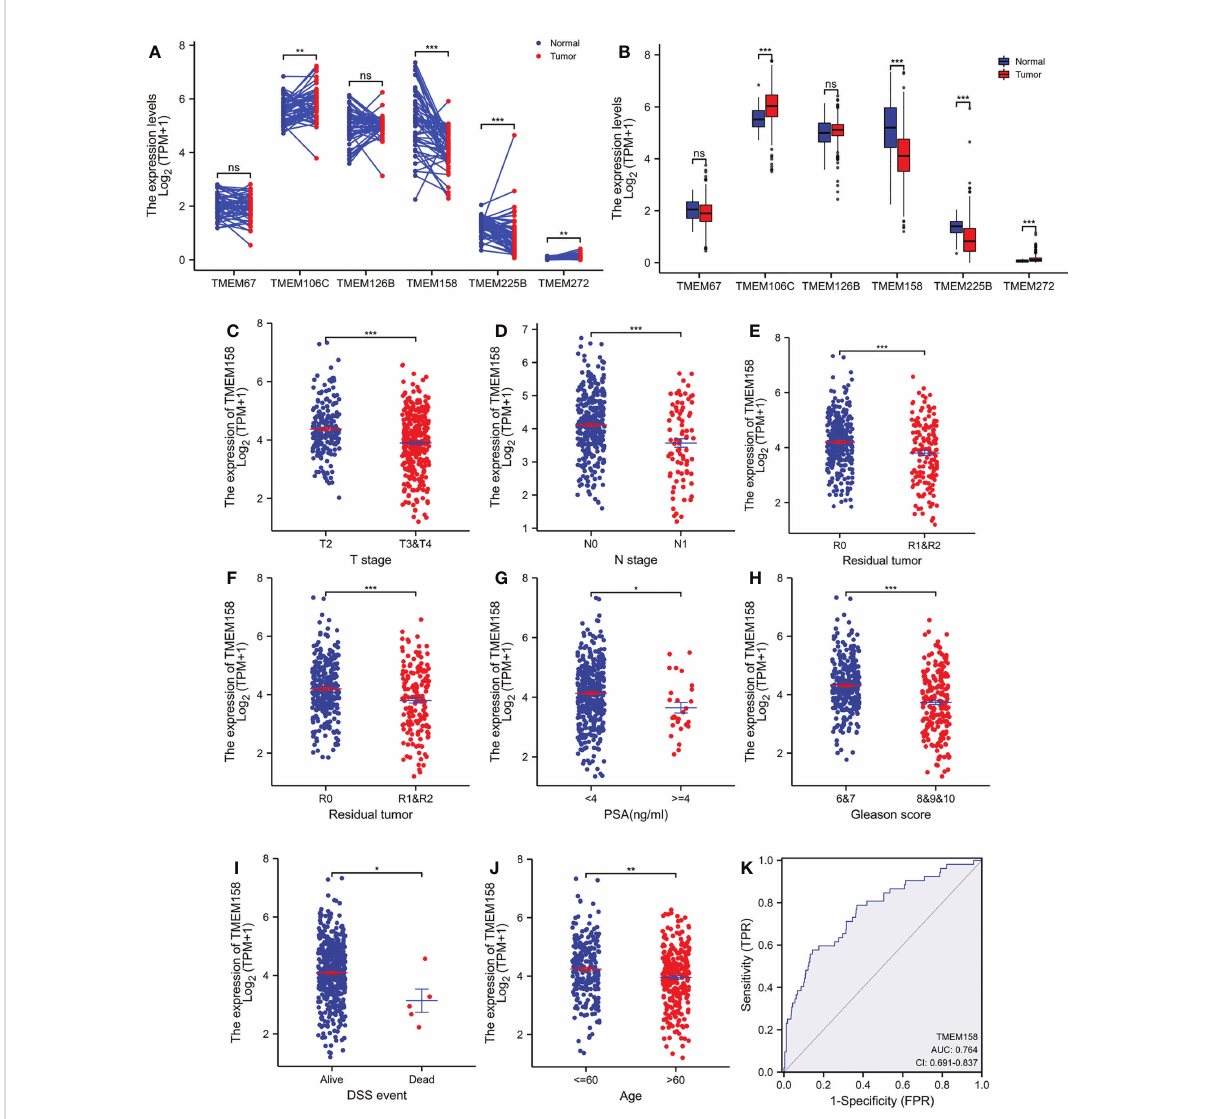
FIGURE 1 TMEM158 expression is downregulated in prostate cancers. (A – B) Gene expression at the mRNA levels was compared between normal and tumor tissues using the TCGA-PRAD RNA-seq dataset with a case-matched pair-wise approach (panel A , n = 52, paired t -test, **p < 0.01, ***p < 0.001) and group cohort approach (panel B , normal n = 52; tumor = 499, Wilcoxon rank sum test, ***p < 0.001). (C – J) TMEM158 expression was compared between different patient groups strati fi ed by clinicopathological categories. The asterisks indicate a signi fi cant difference (Wilcoxon rank sum test, *p < 0.05; **p < 0.01, ***p < 0.001). (K) ROC analysis was conducted for TMEM158 expression in distinguishing normal and tumor